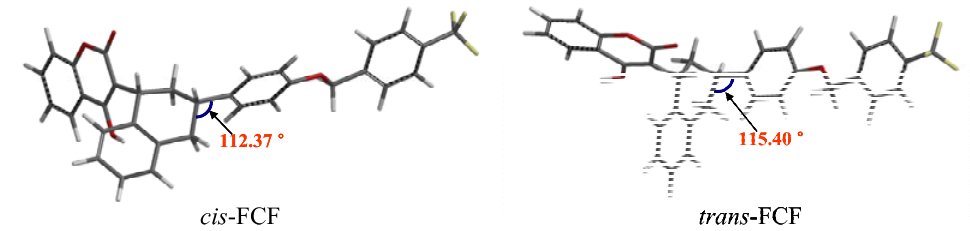
Figure 2. 3D-structures of cis -flocoumafen (left) and trans -flocoumafen (right) generated using SPARTAN 06 for